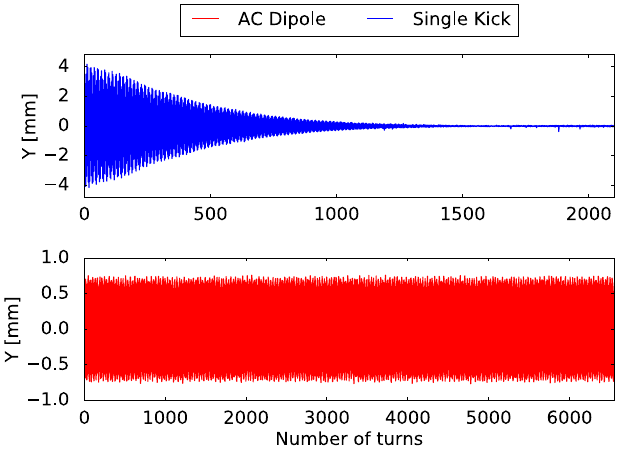
FIG. 4. Comparison between the vertical beam response (top) to a single kick in the LHC at injection energy, and to an ac dipole excitation (bottom)